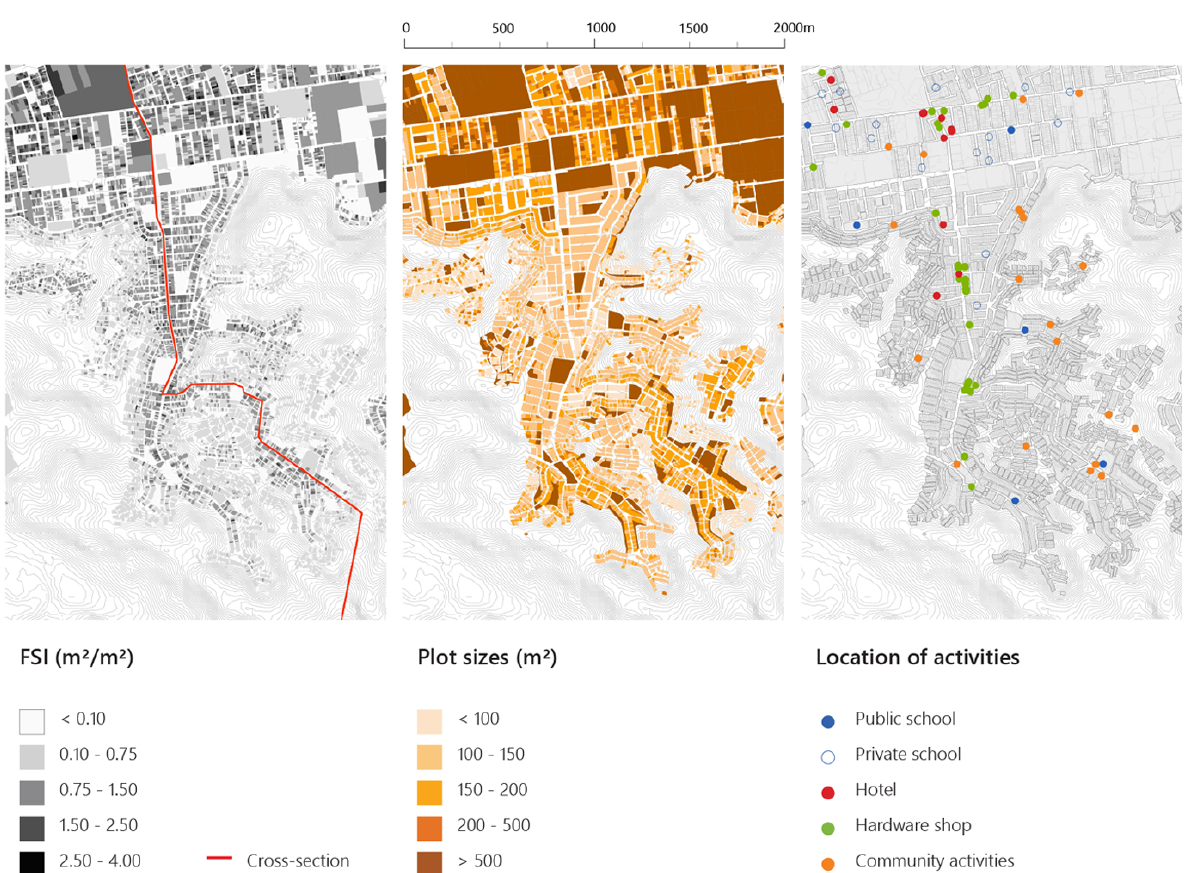
Figure 6. Spatial characteristics and activities in Valle Amauta. Source: Authors, based on data from Ministry of Education of Peru (2019), INEI (2019), Municipality of Ate (2016) and Municipality of Lima